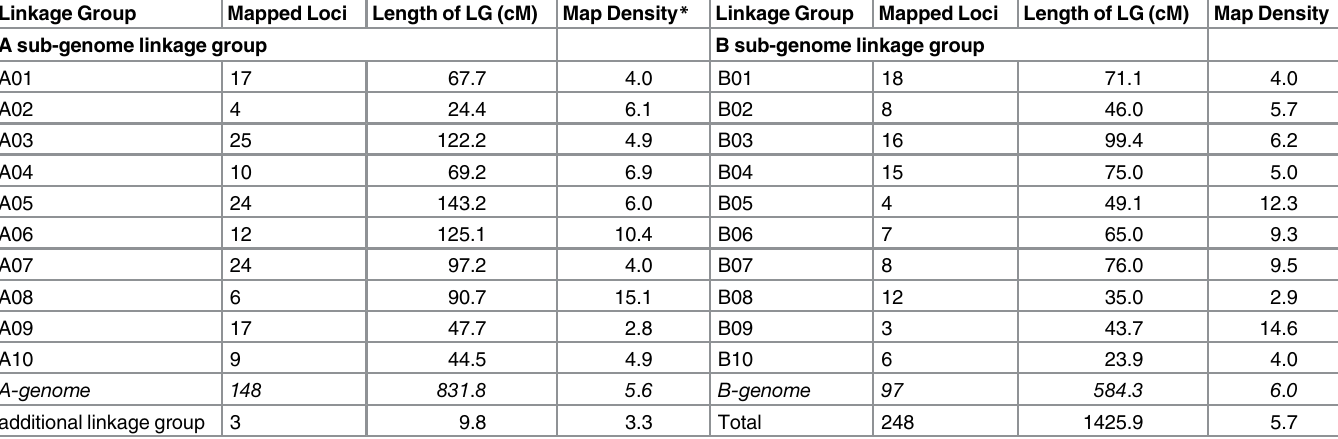
Table 1. Map features of the saturated genetic linkage map with 248 mapped loci of S-population. Linkage